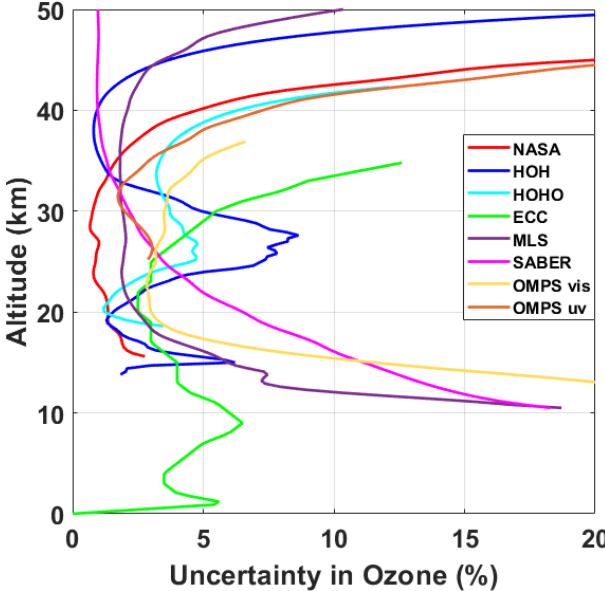
Figure 13. Relative uncertainties in temperature for all HOPS in- struments.